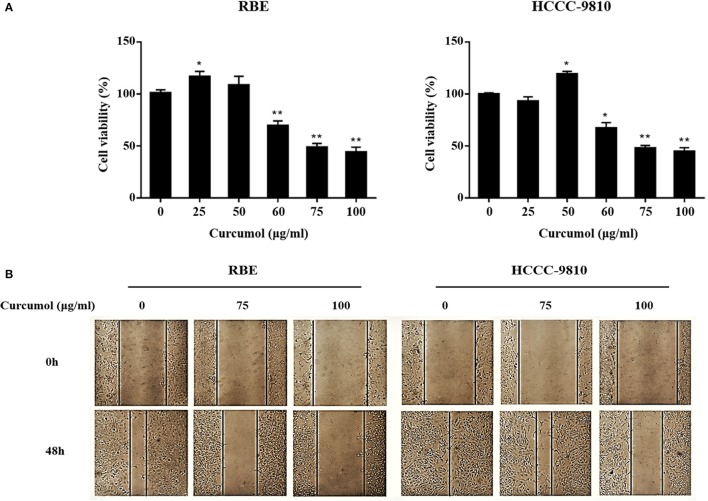
Curcumol inhibits proliferation and migration of CCA cells. Viability of curcumol-treated RBE and HCCC-9810 cells was evaluated by CCK8 assay (A). Effect of curcumol on the migration of RBE and HCCC-9810 cells by scratch assay. Representative images were captured at 48 h after treatment. Data represent mean ± SD from at least three independent experiments (B). *P < 0.05, **P < 0.01, vs. control cells.